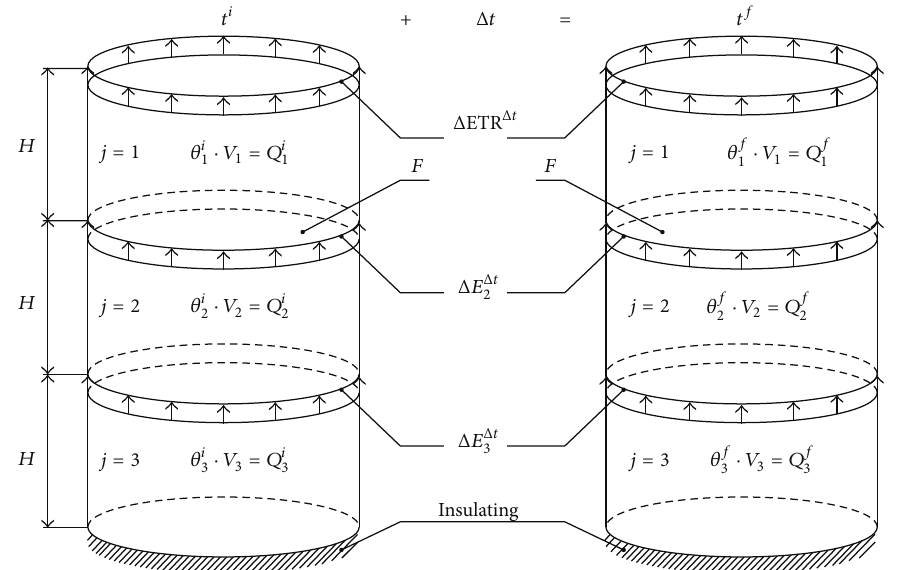
𝑓 ) is volumetric moisture in 𝑗 th layer at the initial 𝑗 3 ],ETR Δ𝑡 isevapotranspiration[mm ⋅ h −1 ],